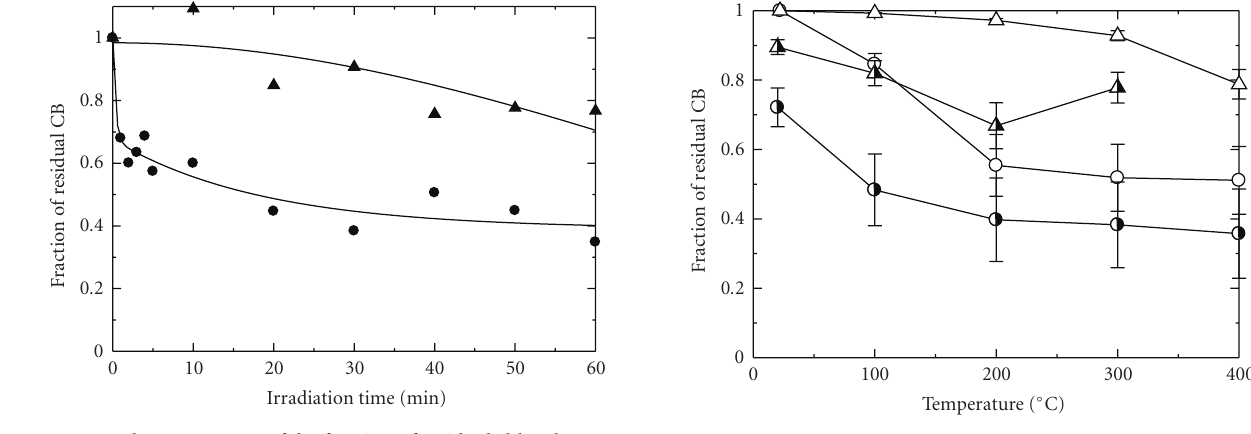
Figure 4: The time course of the fraction of residual chlorobenzene (CB) under near-UV irradiation at room temperature and atmo- spheric pressure. CB = 1mM; : 0.1 wt% TiO 2 ; (cid:5) : without TiO 2 . The solid lines are drawn to guide the eyes.